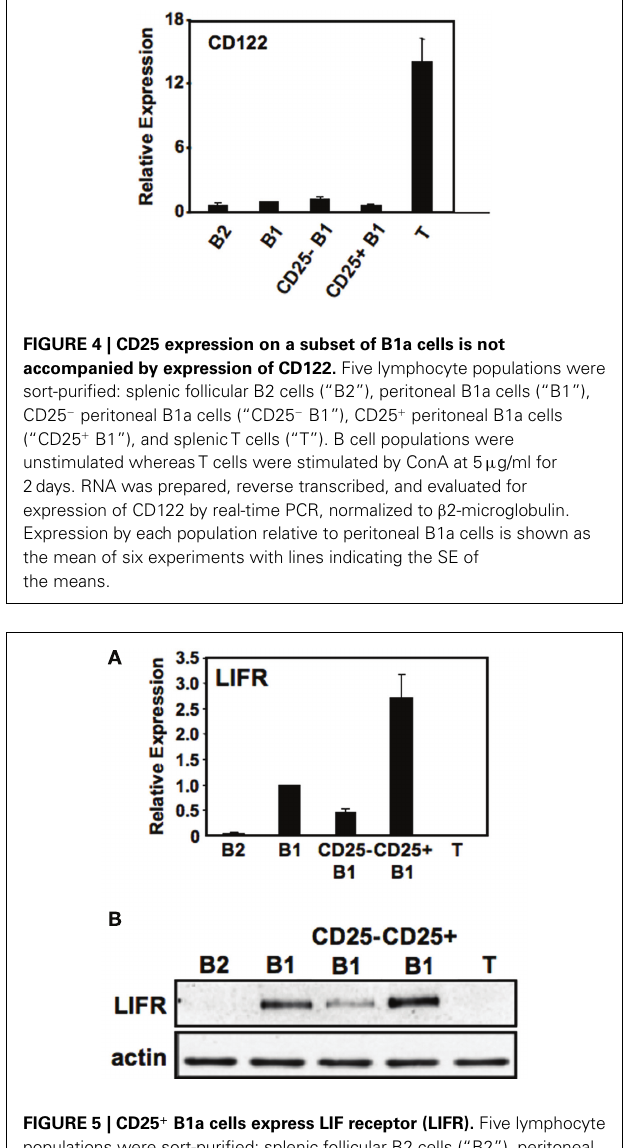
FIGURE 5 | CD25 + B1a cells express LIF receptor (LIFR). Five lymphocyte populations were sort-purified: splenic follicular B2 cells (“B2”), peritoneal B1a cells (“B1”), CD25 − peritoneal B1a cells (“CD25 − B1”), CD25 + peritoneal B1a cells (“CD25 + B1”), and splenicT cells (“T”). (A) RNA was prepared from each of these populations, reverse transcribed,